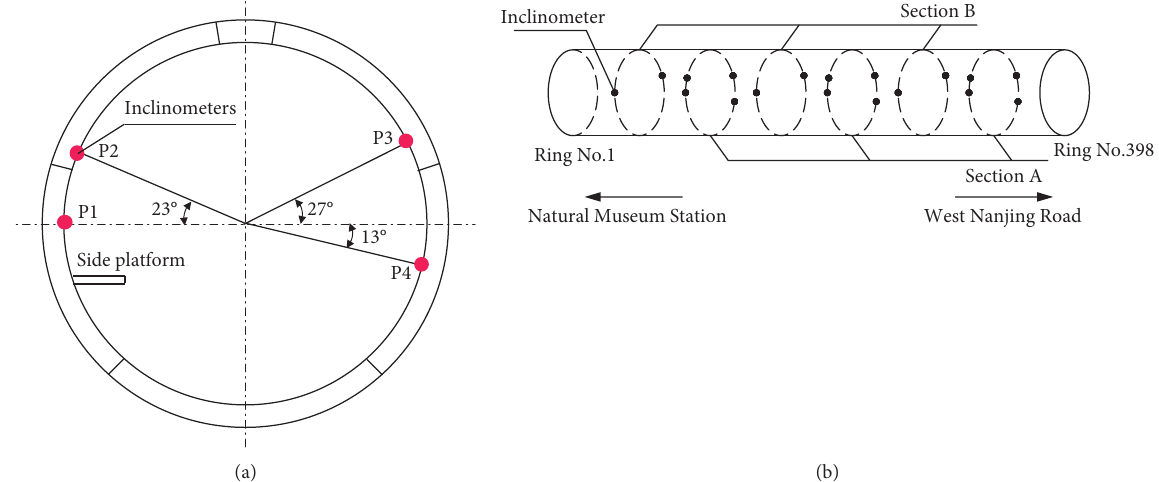
Figure 13: Sensor layout: (a) in a lining ring and (b) in the monitored section.